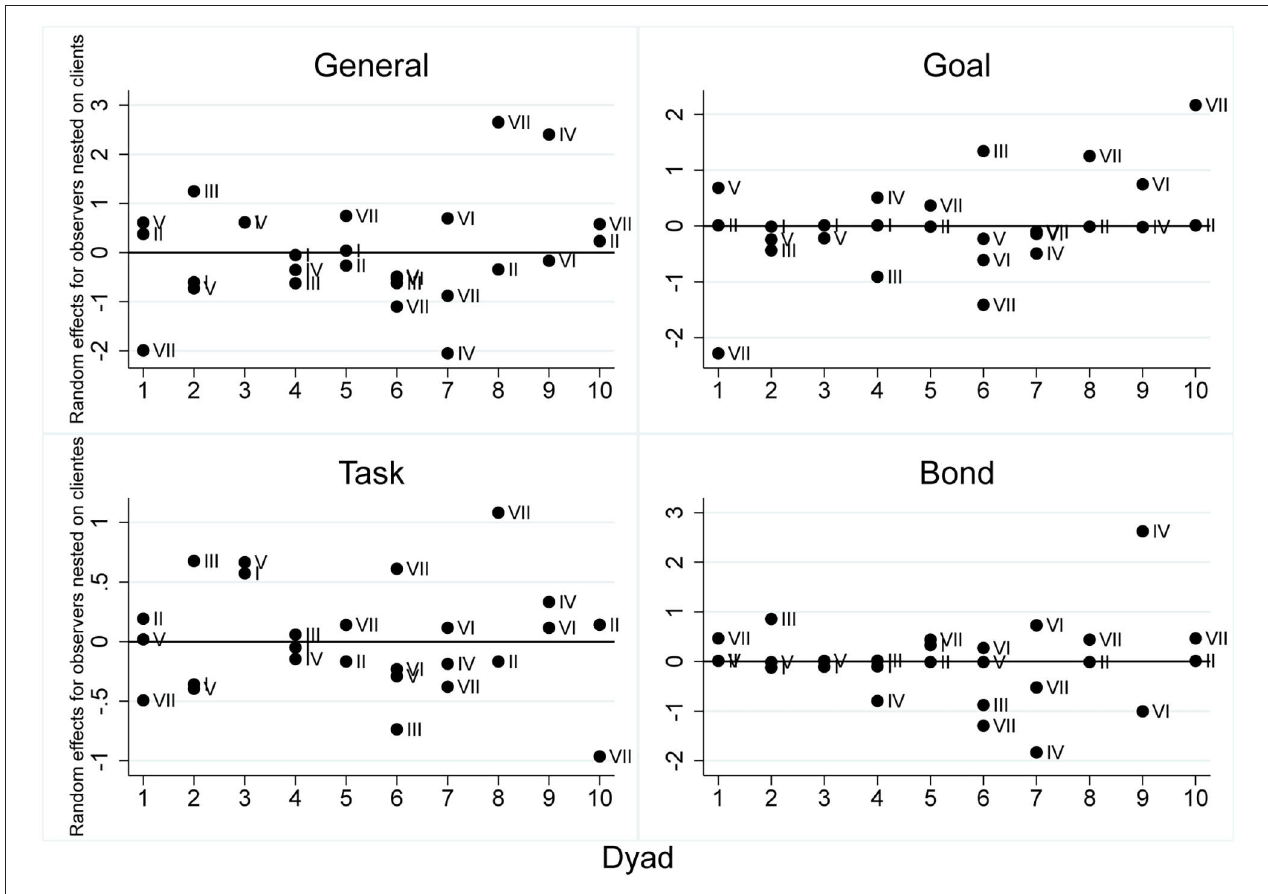
FIGURE 2 | Weighted averages of the WAI-SR-O for the general scales and subscales. The study embraces two clinical trials aiming to evaluate the same protocol. 1–10: clients; I–VII: observes.